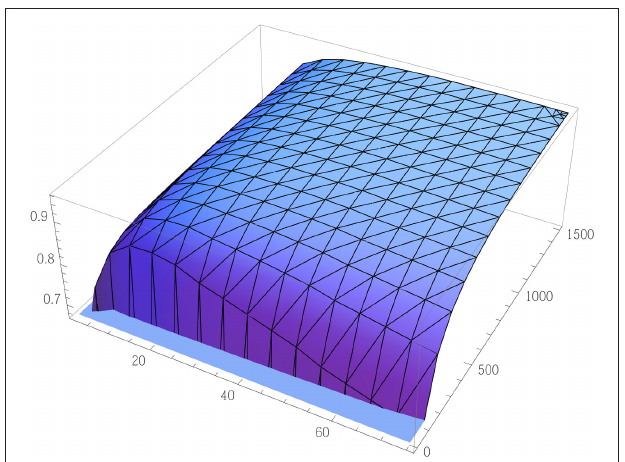
FIGURE 4 | Ideal case efficiency of counterfactual CNOT. The efficiency of an ideally implemented counterfactual CNOT gate, with Alice encoding a quantum superposition of “0” and “1,” plotted against the number of outer and inner cycles M and N, with M up to 75, and N up to 1500. Bob’s control qubit is assumed an equal superposition here. Efficiency approaches unity for N >> M >> 1 . Errors or loss caused by imperfect optical elements and by noise in the channel, as well as decoherence of Bob’s quantum object, all of which have an adverse effect, are ignored here.